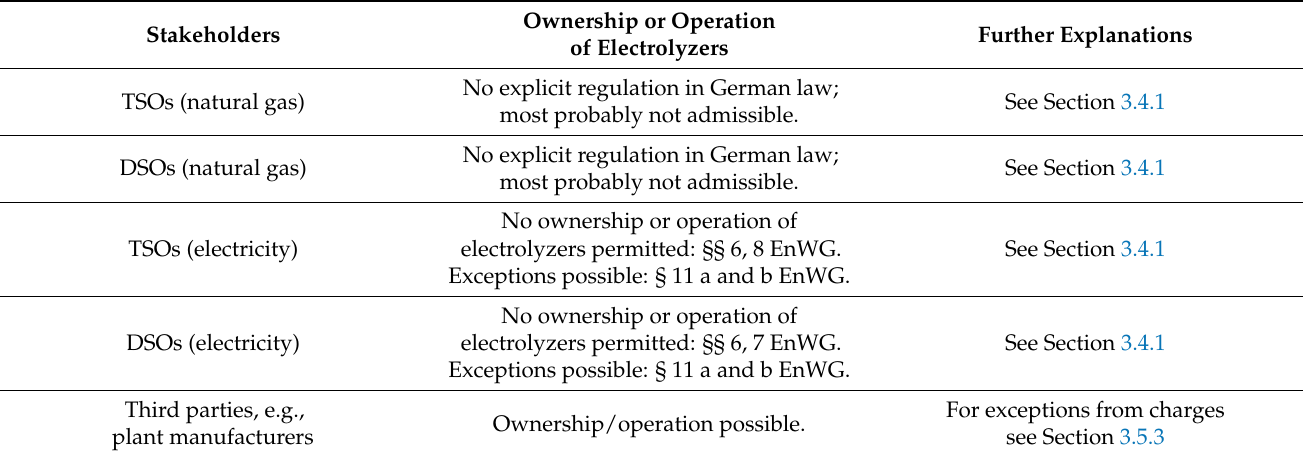
Table 1. Regulation of ownership and operation of electrolyzers in Germany for potential